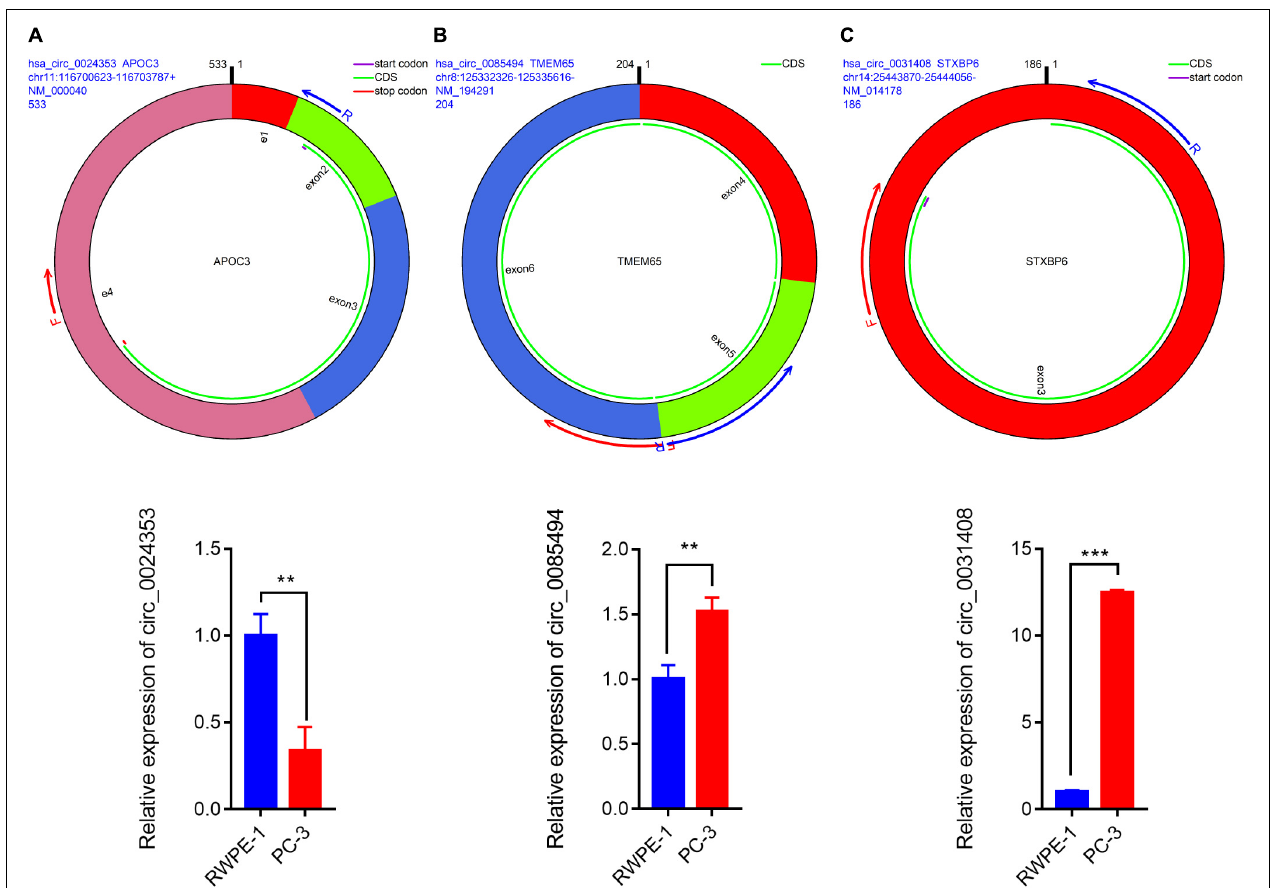
FIGURE 5 | Pattern diagrams of divergent primers spanning back-splicing junctions and qRT-PCR validation of the expression of hsa_circ_0024353 (A) , hsa_circ_0085494 (B) , and hsa_circ_0031409 (C) in RWPE-1 and PC-3 cells. * P < 0.05, ** P < 0.01, and *** P < 0.001.